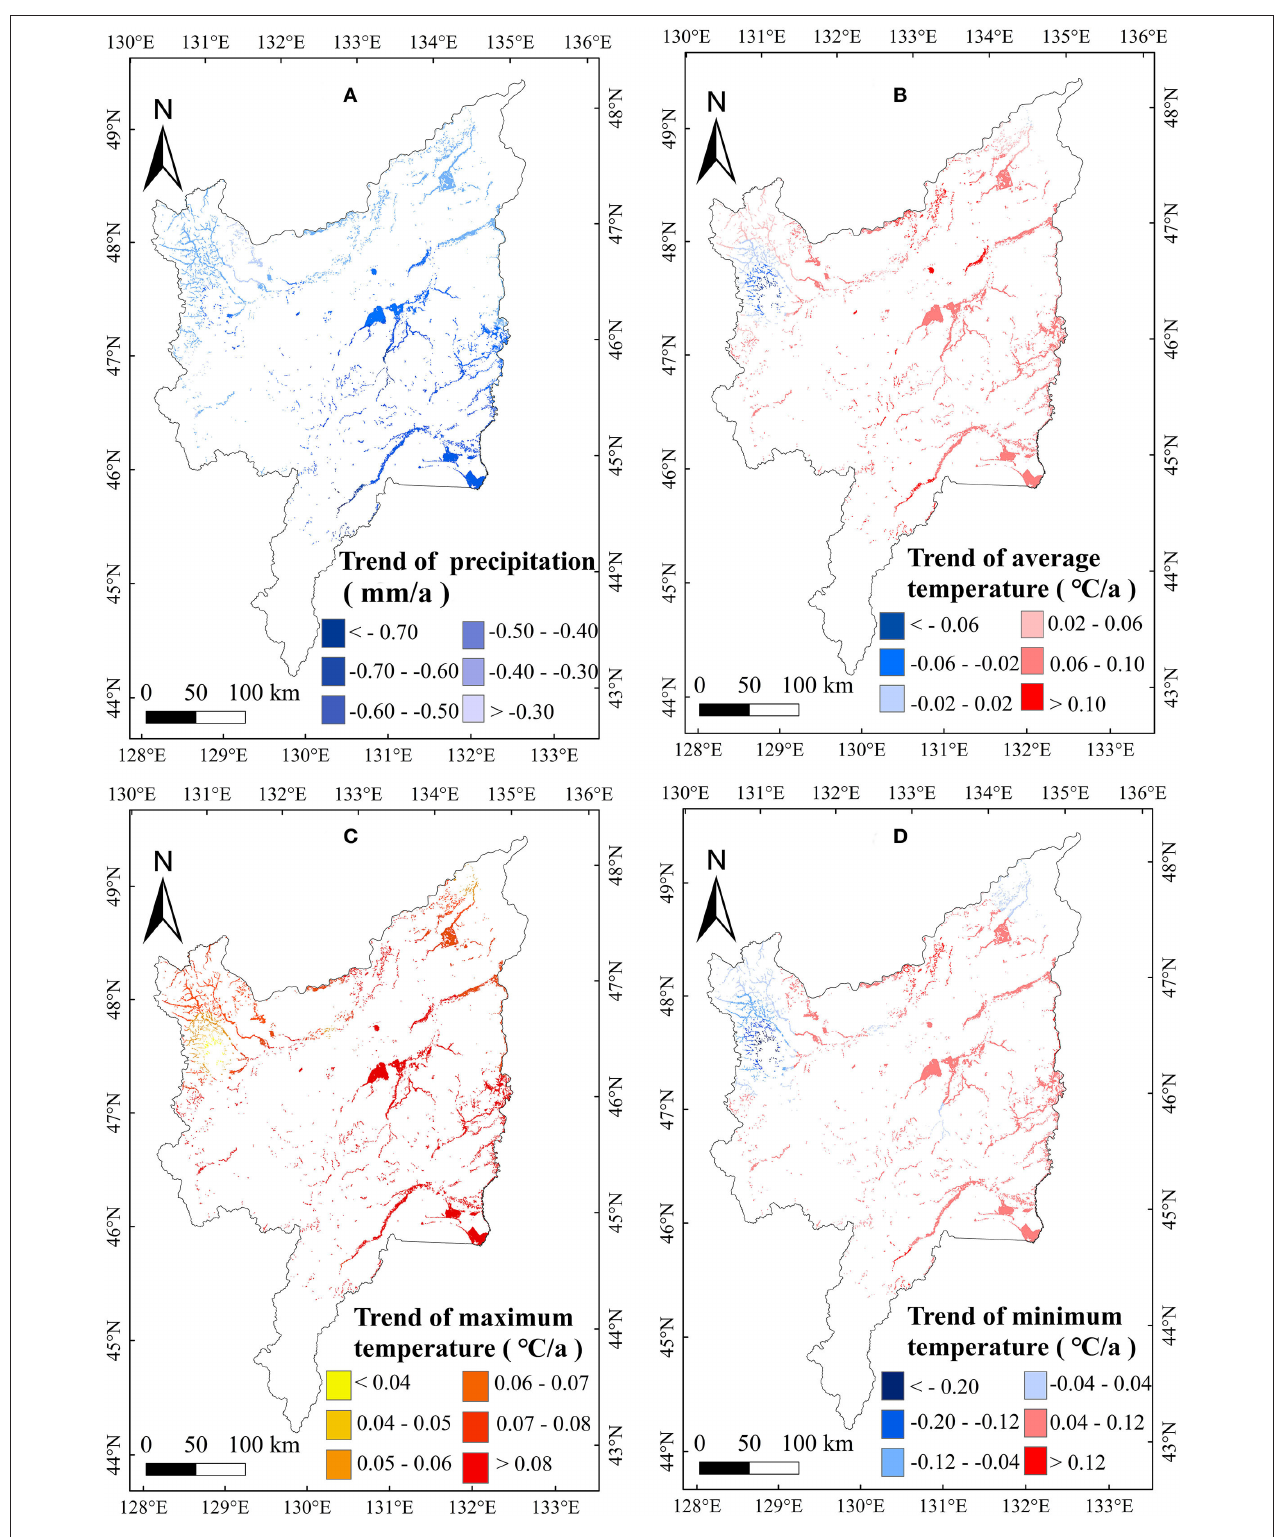
FIGURE 10 | Change trends in precipitation (mm/a) (A) , T mean ( ◦ C/a) (B) , T max ( ◦ C/a) (C) , and T min ( ◦ C/a) (D) in January in marshes of the Sanjiang Plain from 2000 to 2020.